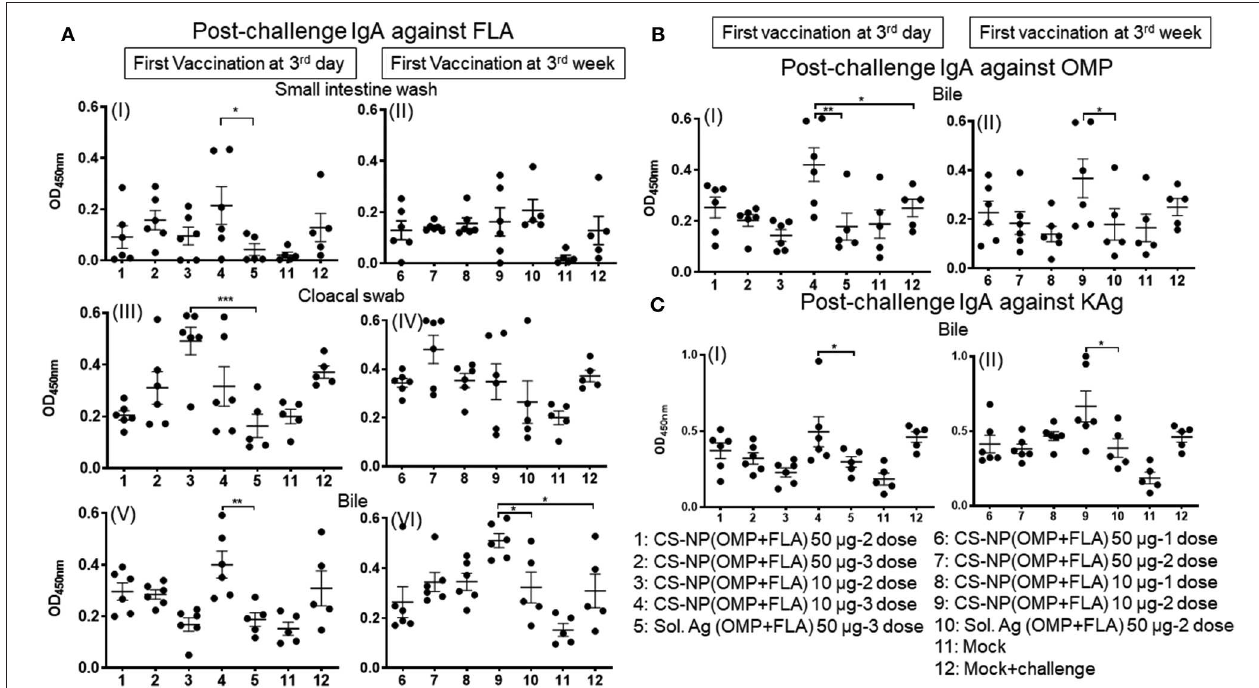
FIGURE 2 | Specific IgA response in vaccinated birds post-challenge infection. Broilers were vaccinated as described in Fig legend 1, challenged at age 5-week, and 10 days later euthanized and samples collected for specific IgA antibody analysis by ELISA: (A) (I and II) Small intestine wash, (III and IV) Cloacal swab, (V and VI) Bile against FLA protein; (B) response against OMP in Bile (I and II); and (C) response against KAg in Bile (I and II). Data were presented as mean ± SEM of 6 or 5 birds. Significant difference between the indicated two groups were determined by one-way ANOVA followed by Tukey post-hoc test. * P < 0.05, ** P < 0.01, *** P < 0.001.